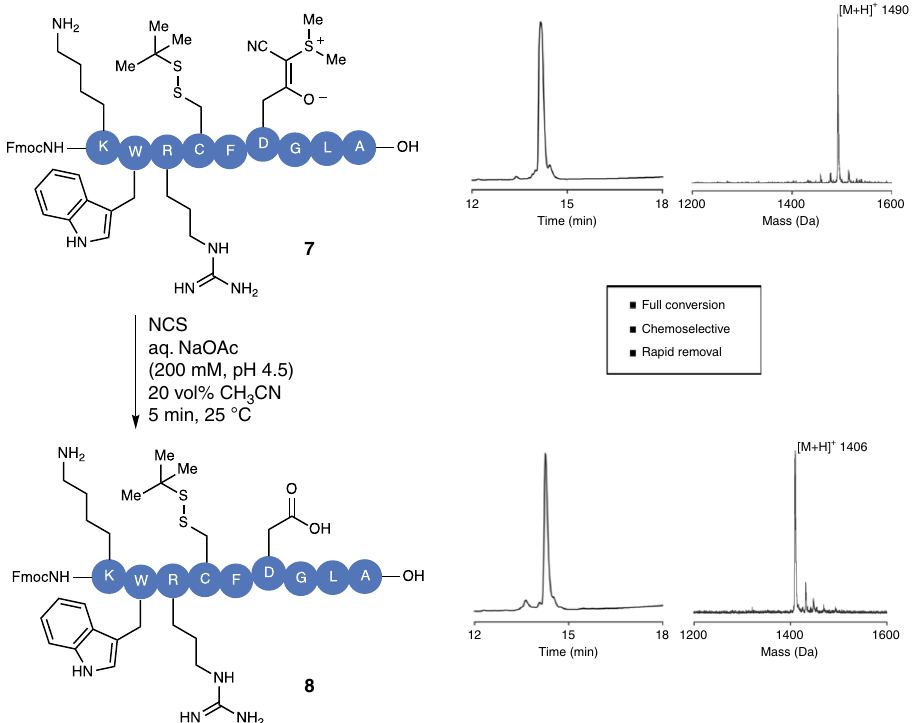
Fig. 3 Chemoselective removal of cyanosulfurylides. In solution removal of cyanosulfurylide in the presence of oxidation-sensitive residues including tryptophan and S t Bu protected cysteine. NCS was titrated to the solution until full conversion was indicated by HPLC and mass spectrometry. Reaction went to completion within 5 min at 25 °C without any side-product being observed by HPLC and mass